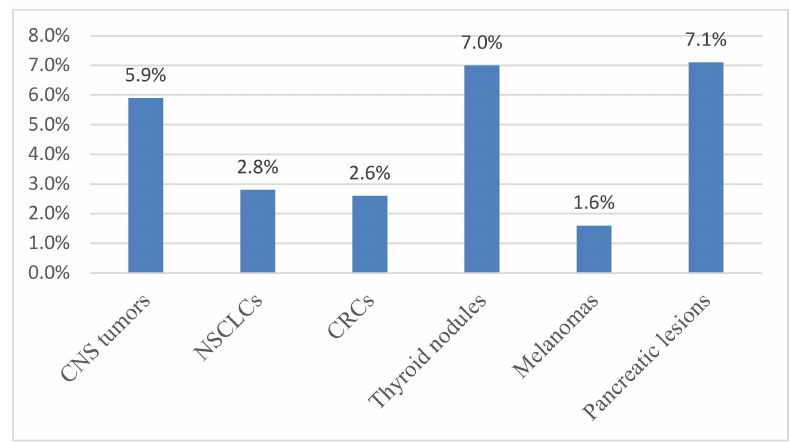
Figure 3. Percentage of cases with no amplifiable DNA. Y -axis: frequency of not-amplifiable samples; X -axis: Type of lesions analyzed. CNS: central nervous system; NSCLCs: non-small cell lung carcinomas; CRCs: colorectal